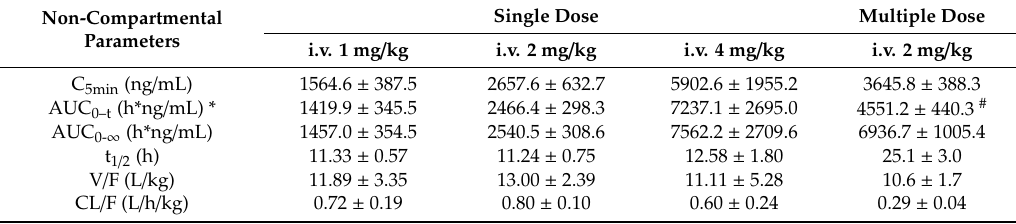
*: AUC represents area under the plasma concentration versus time curve from 0–72 h. # : AUC represents area under the plasma concentration versus time curve from 0–24 h. C 5min : the plasma concentration of GC20 at 5 min after intraveous administration which could be directly obtained from the plasma concentration versus time